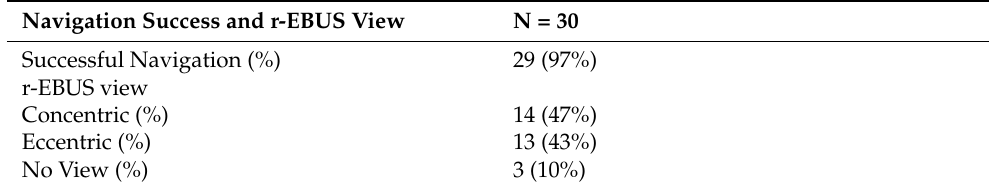
Table 2. Navigation Success and r-EBUS